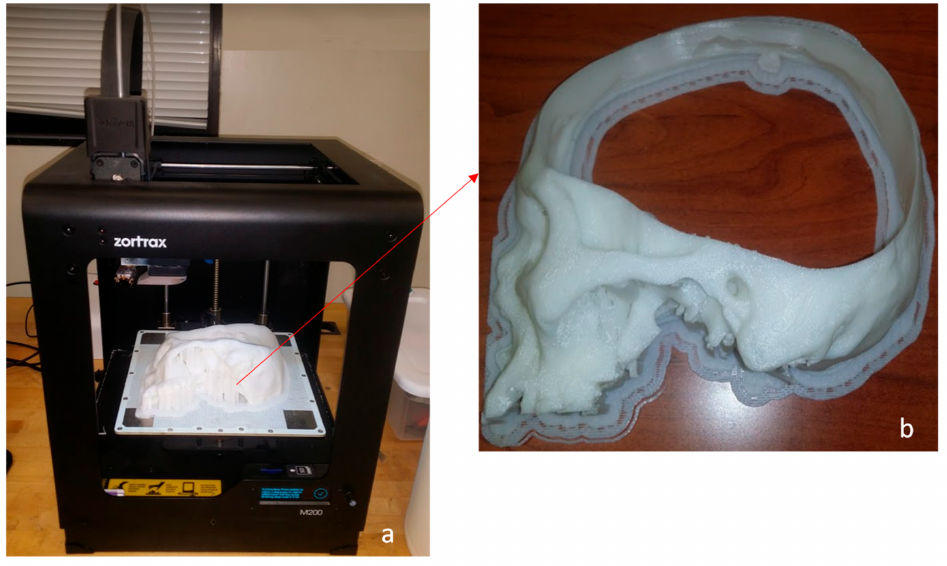
Figure 3. ( a ) Zortrax additive manufacturing (AM) machine with the fabricated ( b ) polymer skull.